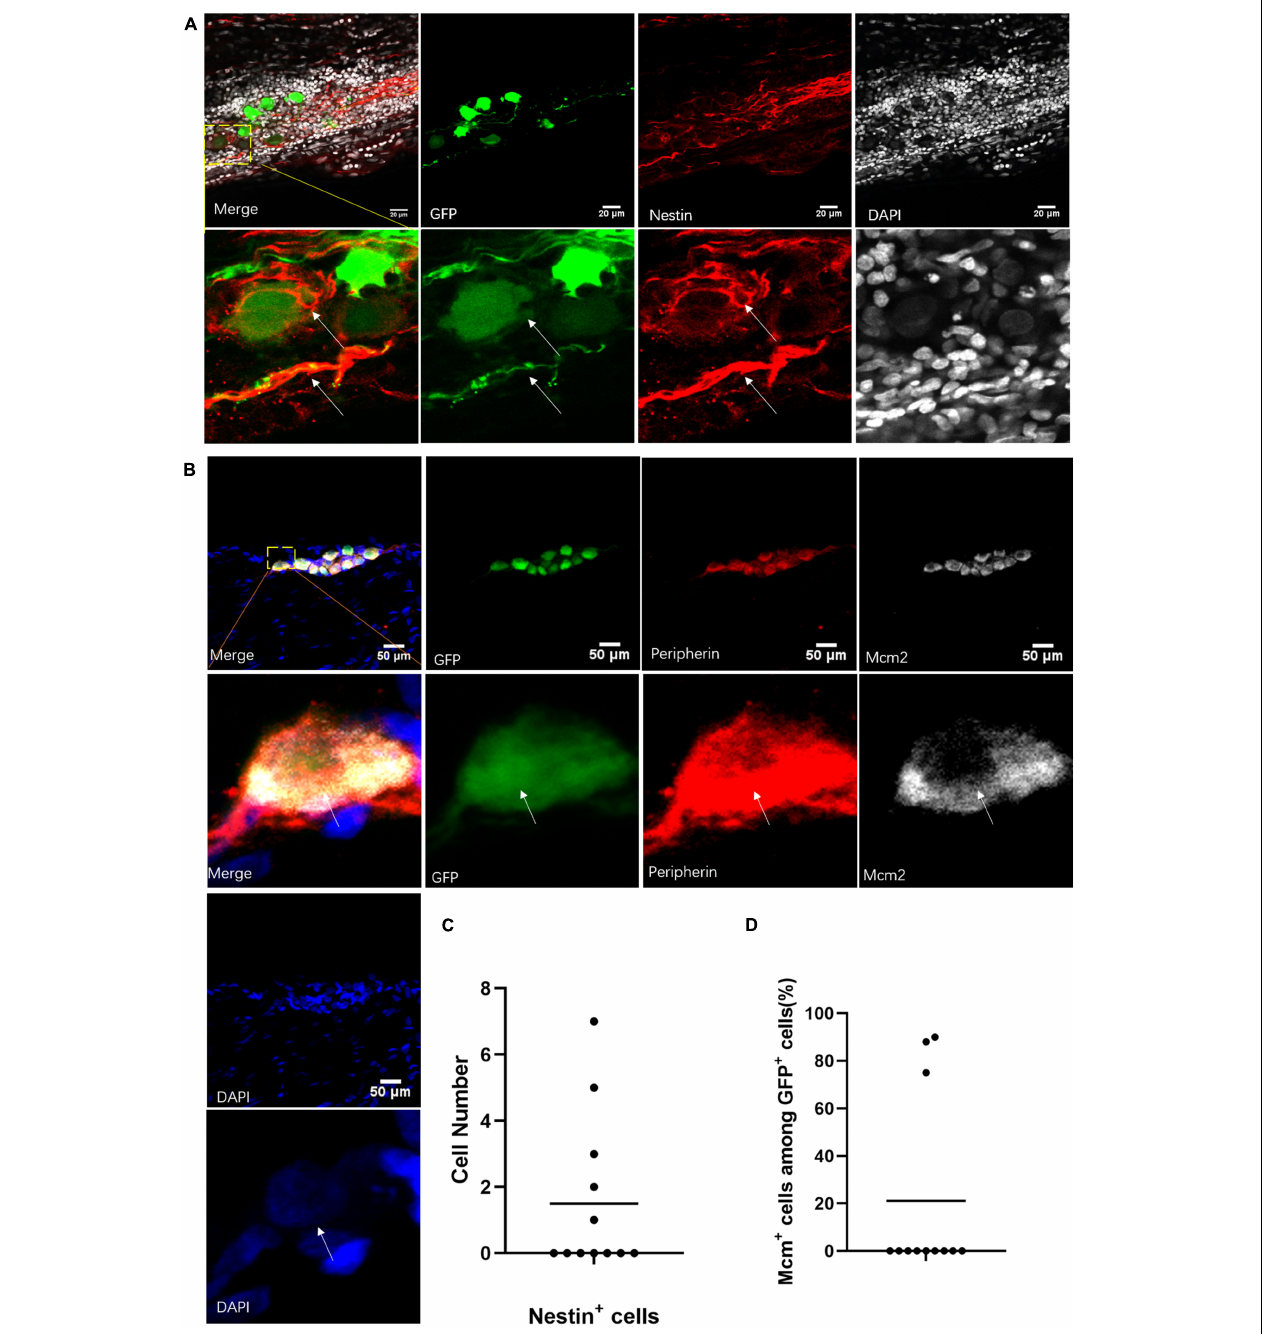
FIGURE 6 | Neuronal stem-like cells in sciatic nerves of adult rats. (A) Stem cell marker staining of neuronal cells in sciatic nerves after virus injection. Immunofluorescent staining for Nestin (red) and DAPI (gray) of GFP + (green) neuronal cells after infection of hSYN -promoter GFP AAV2/9 virus. n = 12 ( GFP + sciatic nerves), n = 5 ( Nestin + sciatic nerves). Scale bar, 20 µ m. (B) Neuronal cells in a phase of division. Confocal images of immunostaining of Mcm2 (gray), Peripherin (red), and DAPI (blue) in GFP + (green) neuronal cells. The sciatic nerves were infected by hSYN -promoter GFP AAV2/9 virus. n = 12 (sciatic nerves with GFP + neuronal cells), n = 3 ( Mcm2 + sciatic nerves). Scale bar, 50 µ m. (C) The quantification of the number of Nestin + cells in the sciatic nerves with neuronal cells. The sciatic nerves with neuronal cells were infected by hSYN -promoter GFP AAV2/9 virus ( n = 5 of 12 which contain Nestin + cells, the other without Nestin + cells). (D) The quantification of the percentage of Mcm2 + cells among all GFP + neuronal cells in the sciatic nerves. The cultured sciatic nerves were infected by hSYN -promoter GFP AAV2/9 virus. The circle points represent the percentage of Mcm2 + cells among GFP + cells ( n = 3). The white arrow points to the positive cells.